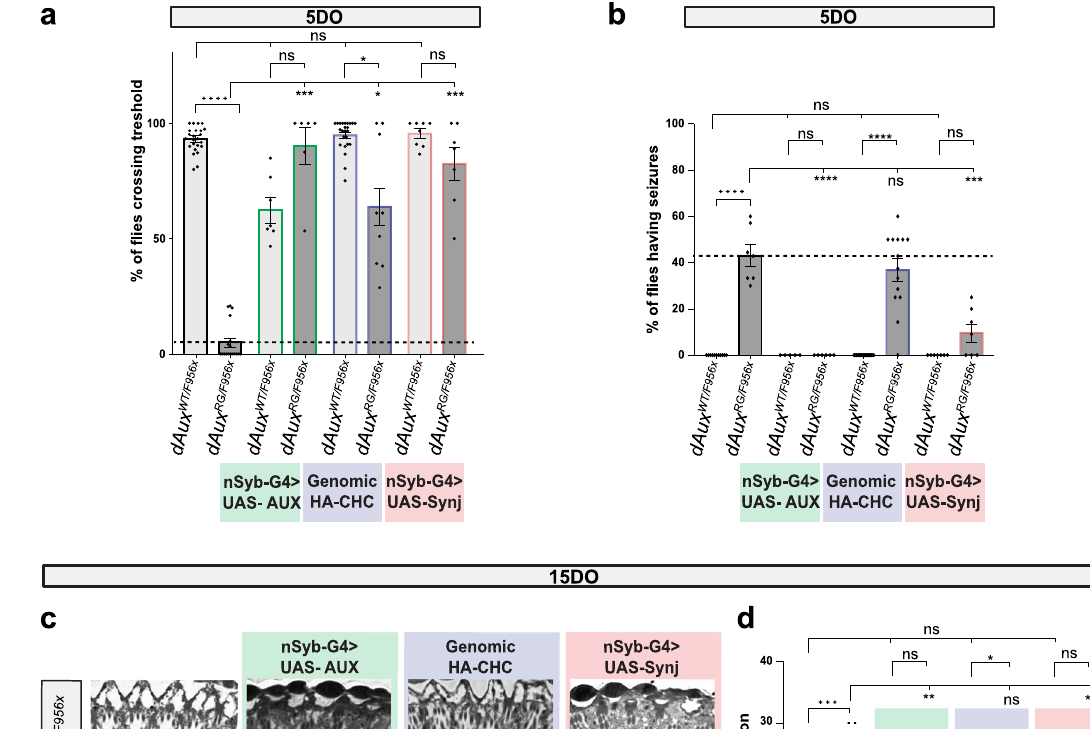
vials and stimulmated by vortexing of the vial for 10 s a maximum intensity. Numbers of active and fl ies that were unable to stand were quanti fi ed 5 s later. Graphs are presented in % of fl ies having seizures 86 .